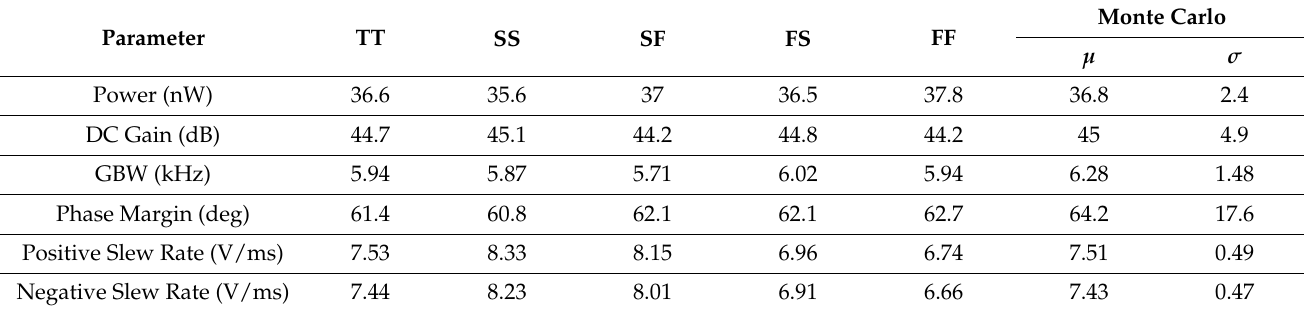
Table 5. Corner and Monte Carlo analysis results for T = 85 ◦ C.